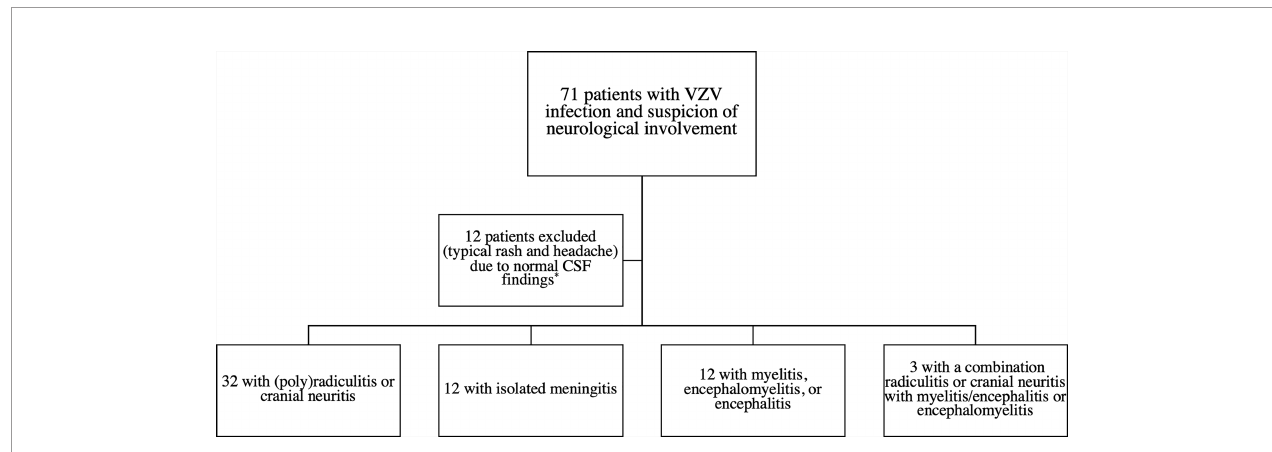
FIGURE 2 | Inclusion fl owchart VZV infection with neurological involvement. * Negative CSF VZV speci fi c antibody index, VZV DNA PCR and normal CSF cell count. CSF, cerebrospinal fl uid; VZV, varicella zoster virus.